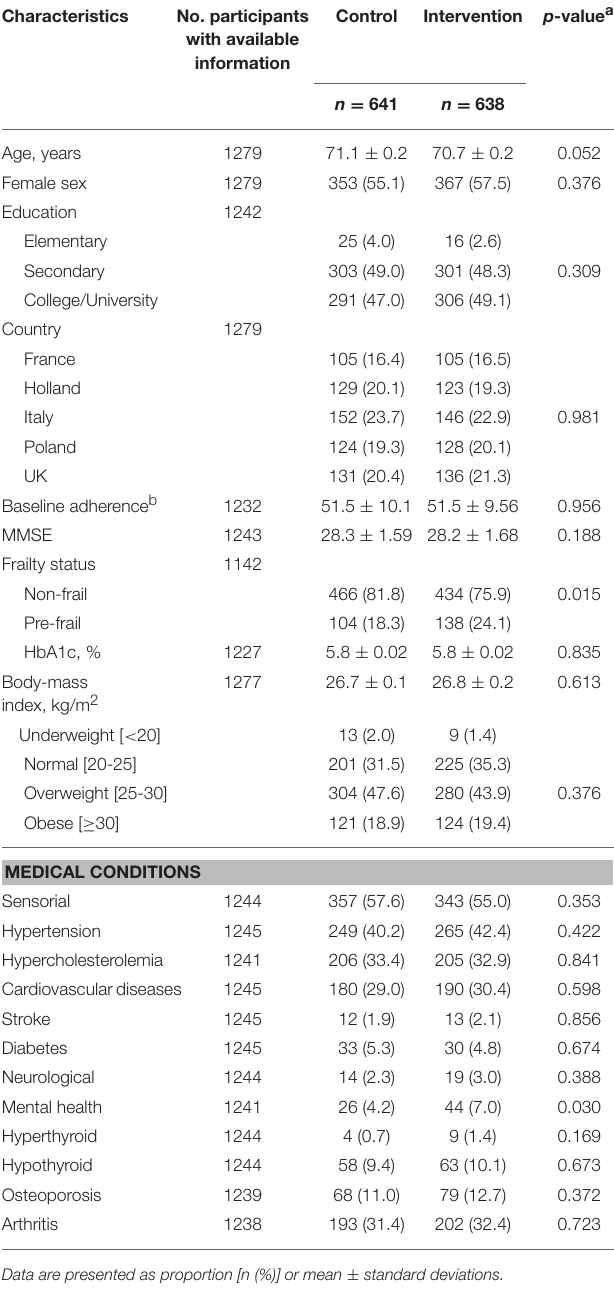
TABLE 2 | Baseline demographics and health characteristics of NU-AGE study participants ( n = 1279).